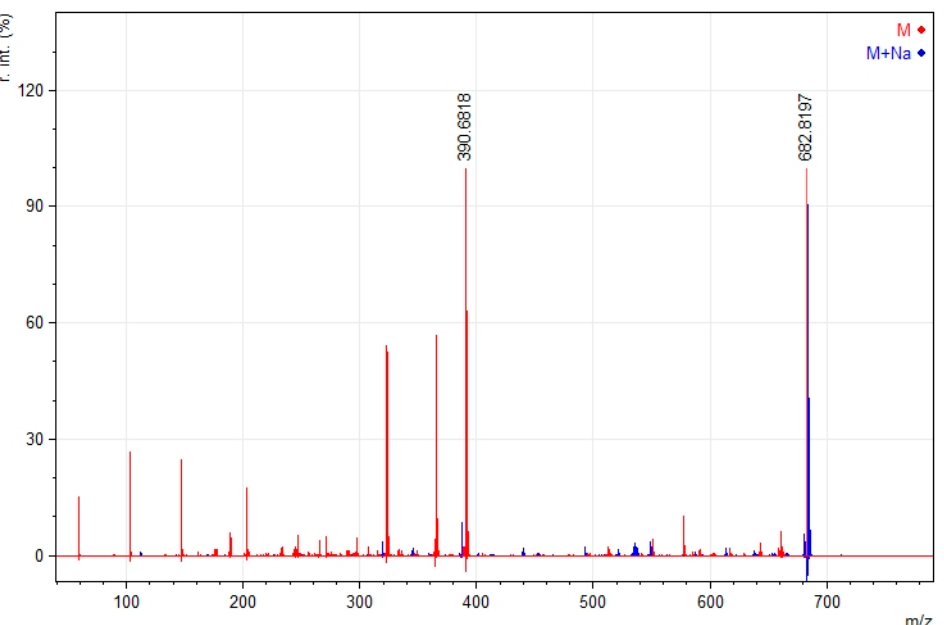
Figure 4. Mass spectrum of compound 4 with the presentation of fragmentations; [M+Na] + sodium